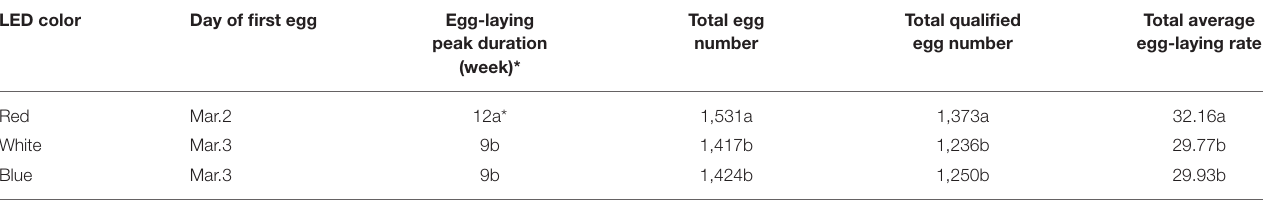
TABLE 3 | Egg-laying peak duration, total egg number, total qualified egg number and total average egg-laying rate for Zi-geese under different color LED